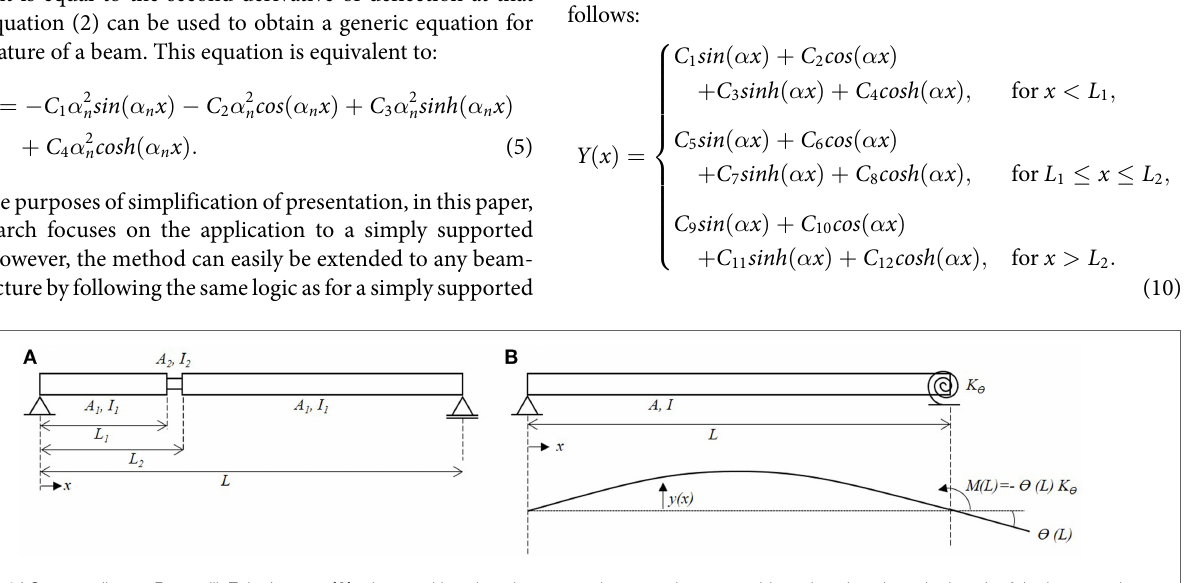
FIGURE 1 | Case studies on Bernoulli–Euler beams: (A) a beam with reduced cross-section occurring at an arbitrary location along the length of the beam and (B) a beam with partially fixed end at the support.